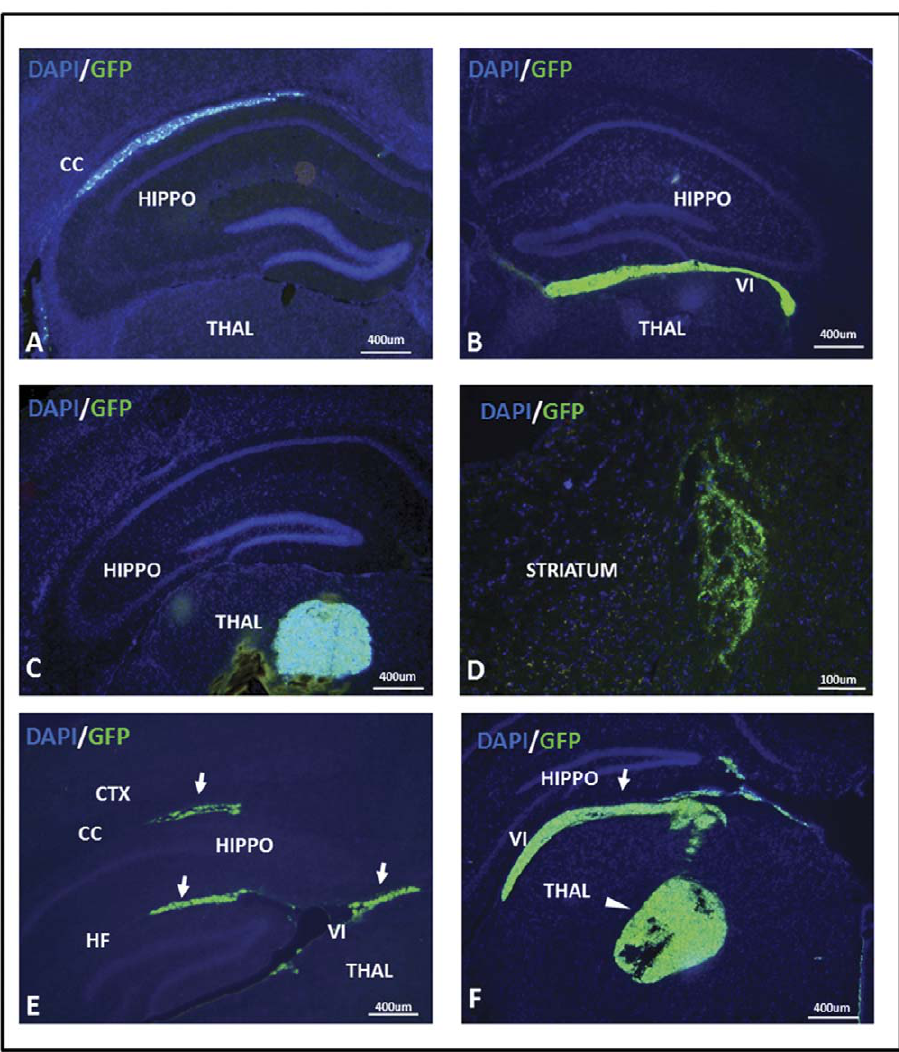
Figure 8. Short-term engraftments demonstrate the hippocampus specifically features anisotropic transport. NSCs were surgically infused into the brains of non-transgenic mice that were then sacrificed within fifteen minutes after cessation of infusion to observe near-immediate transplant distribution. NSCs infused proximal to the superior aspect of the septal hippocampus (HIPPO) were mainly distributed along the transverse plane of the corpus callosum (CC) (A). Similarly, NSCs distributed along the transverse plane of the velum interpositum (VI) when deposited more ventrally in the inferior aspect of the hippocampus (B). Engraftments in the thalamus (THAL) (C) and striatum (D) did not preferentially distribute in the transverse plane. 38.5% of infusions resulted in independent anisotropic (ellipsoid; arrows) and isotropic (circular; arrowheads) engraftments distal to the target site including the hippocampal fissure (HF) (E–F). GFP fluorescence was detected directly in all panels. The images shown are representative of an analysis of at least three tissues sections (each) from a minimum of three